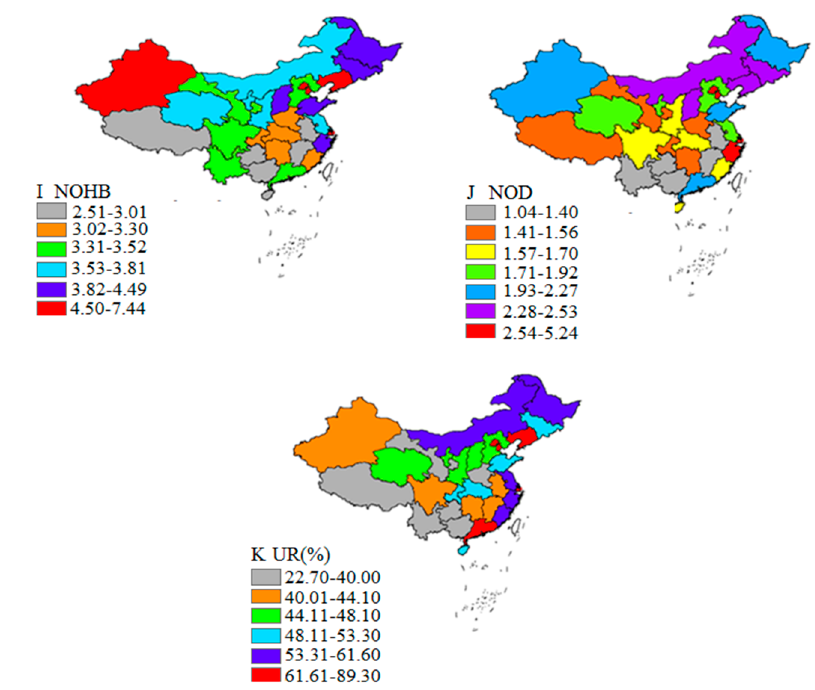
Figure 3. Spatial distribution map of social and environmental factors of LE in China in 2010. ( A ) Distribution of BR (Birth rate); ( B ) Distribution of TDR (Total dependency rate); ( C ) Distribution of NORPH (Number of residents per household); ( D ) Distribution of WRPC (Water resource per capita); ( E ) Distribution of CLOUR (Consumption level of urban residents); ( F ) Distribution of GPC (GDP per capita); ( G ) Distribution of NOCS (Number of college students per 100,000 persons; ( H ) Distribution of MCEOUR (Medical care expenditure of urban residents); ( I ) Distribution of NOHB (Number of hospital beds per 1000 persons); ( J ) Distribution of NOD (Number of doctors per 1000 persons); ( K ) Distribution of UR (Urbanization rate).